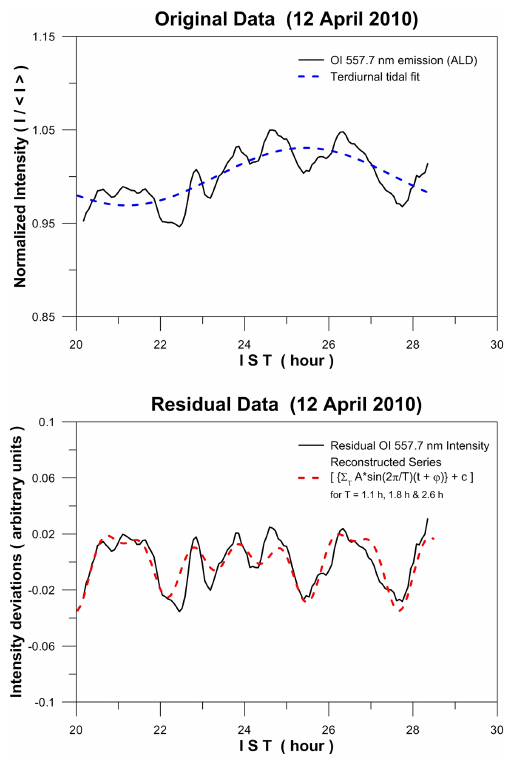
Figure 3. Nocturnal variation of OI 557.7nm emission intensity on 12–13 April 2010 (top panel). The broken curve represents the si- nusoidal least square fit applied to OI 557.7nm emission intensity. The variation of residual intensity obtained after removal of terdi- urnal tidal trend from original time series of OI 557.7nm emission intensity (bottom